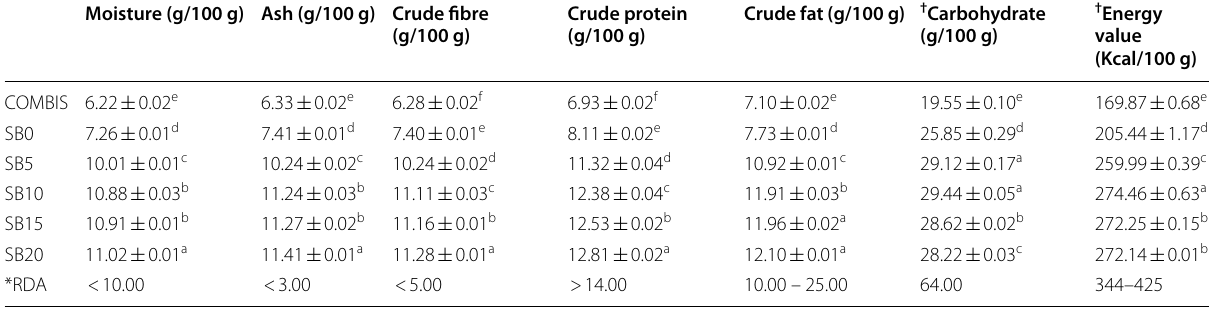
Values are expressed as mean SD ( n 3). Values with different letters down the columns are significantly different at p < 0.05. ± = † Calculated values. COMBIS: Commercial onion biscuit; SB0: 100% Plantain biscuit, SB5: 95% Plantain 5% Shallot biscuit, SB10: 90% Plantain + SB15: 85% Plantain 15% Shallot biscuit, SB20: 80% Plantain 20% Shallot biscuit. *RDA Recommended Dietary Allowance (Suitor and Murphy 2013; WHO 2003) + + = Table 3 Mineral composition of shallot-enriched plantain biscuits (Dry weight basis)